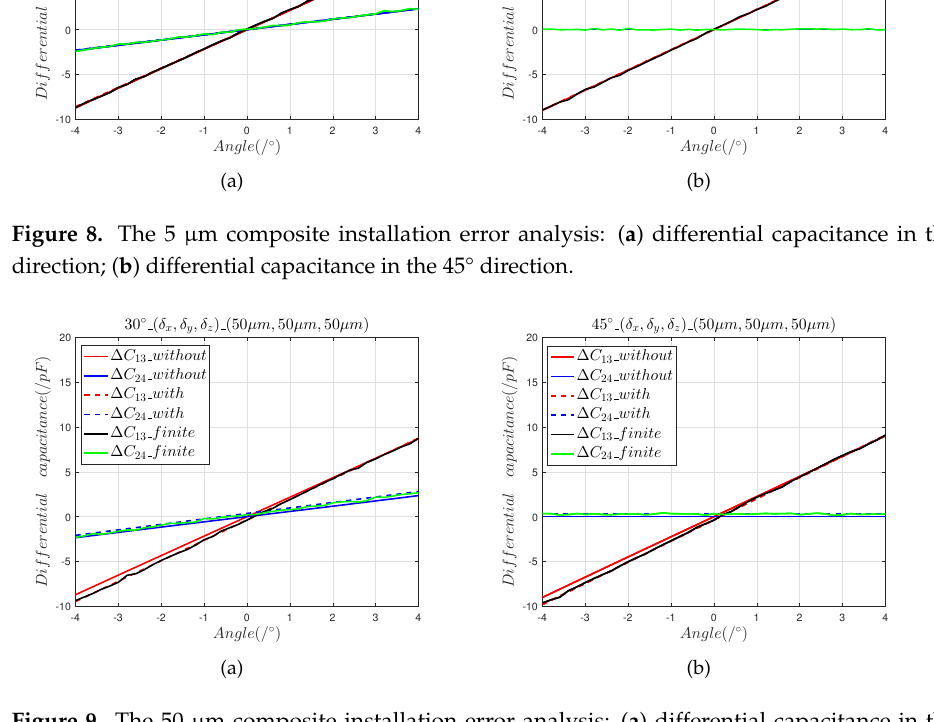
Figure 9. The 50 µ m composite installation error analysis: ( a ) differential capacitance in the 30° direction; ( b ) differential capacitance in the 45°